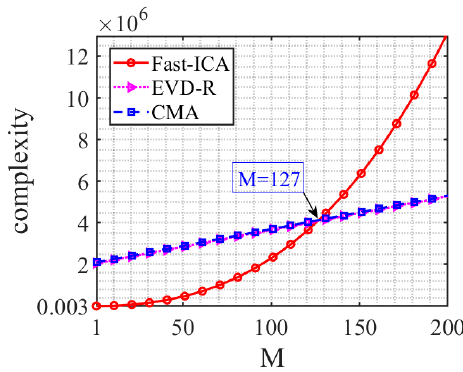
Figure 3. Complexity variation curve versus M.